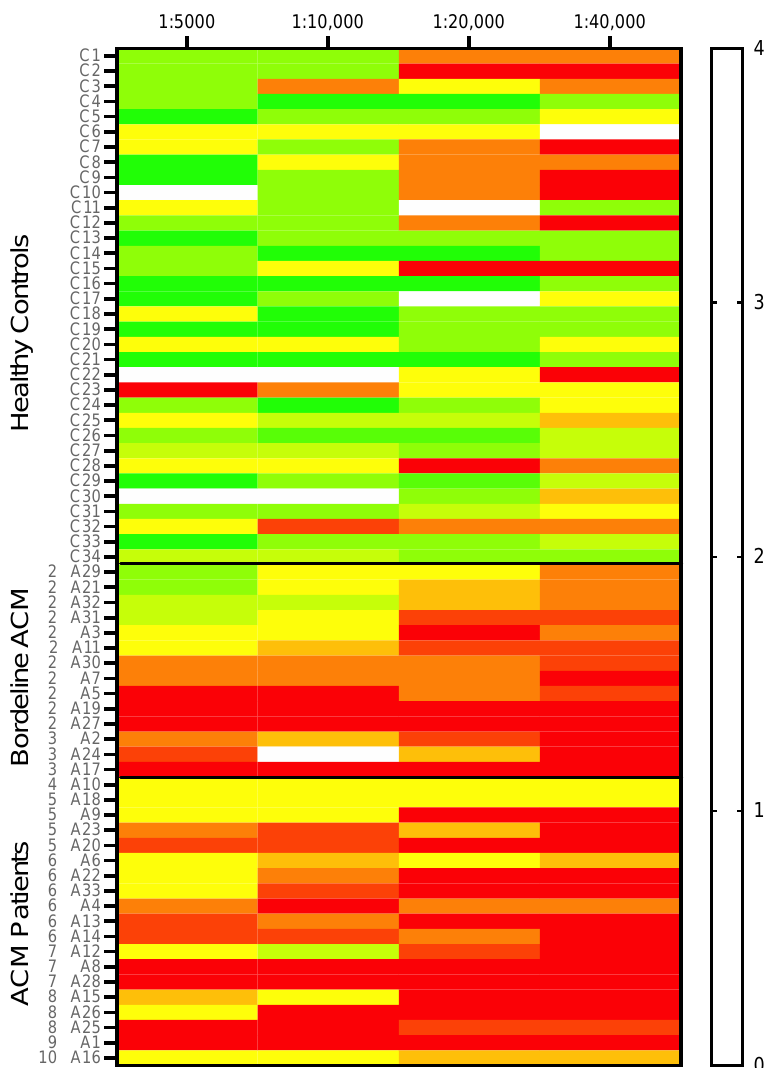
Figure 4. A heat map visualizing the plakoglobin score of all individual subjects (healthy controls n = 34, borderline ACM n = 14 and ACM diagnosed patients n = 19) for all four dilutions. A clear pattern is visible where healthy controls in general tend to show higher scores than borderline and ACM-diagnosed patients. Colors correspond to the score as shown in the right panel. At the left axis, controls (C) and ACM patient (A) numbers are indicated. Furthermore, for each ACM patient their TFC score is listed. ACM; arrhythmogenic